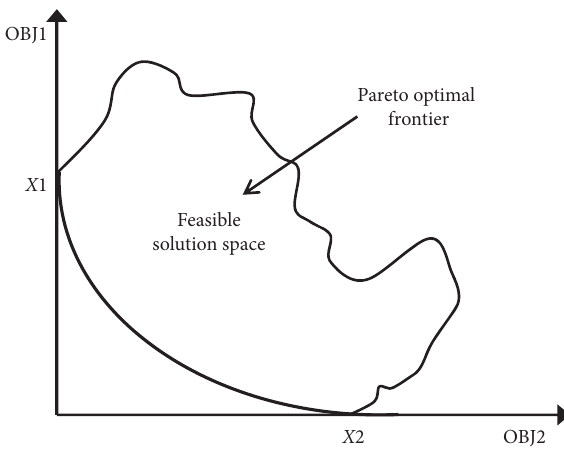
Figure 3: Schematic diagram of Pareto optimal